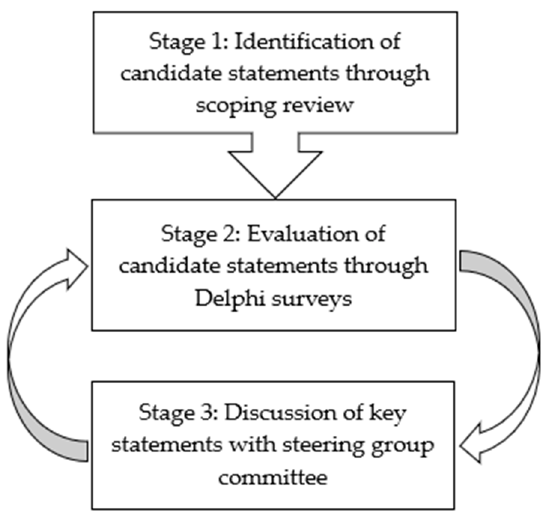
Figure 1. Flow Diagram of the Study.